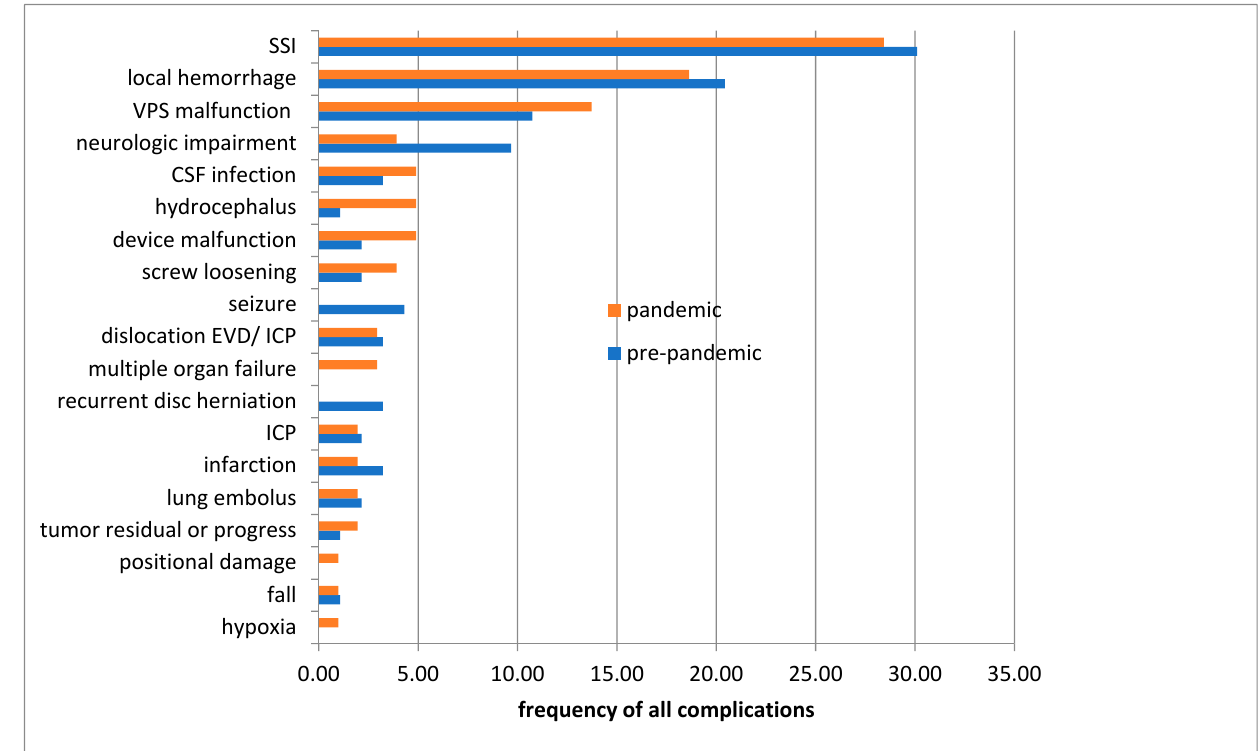
Figure 2. Perioperative complications in the pandemic and pre-pandemic patient group. ICP, intracranial pressure; EVD, external ventricle drainage, CSF, cerebrospinal fluid; VPS, ventriculoperitoneal shunt; SSI, surgical site infections.